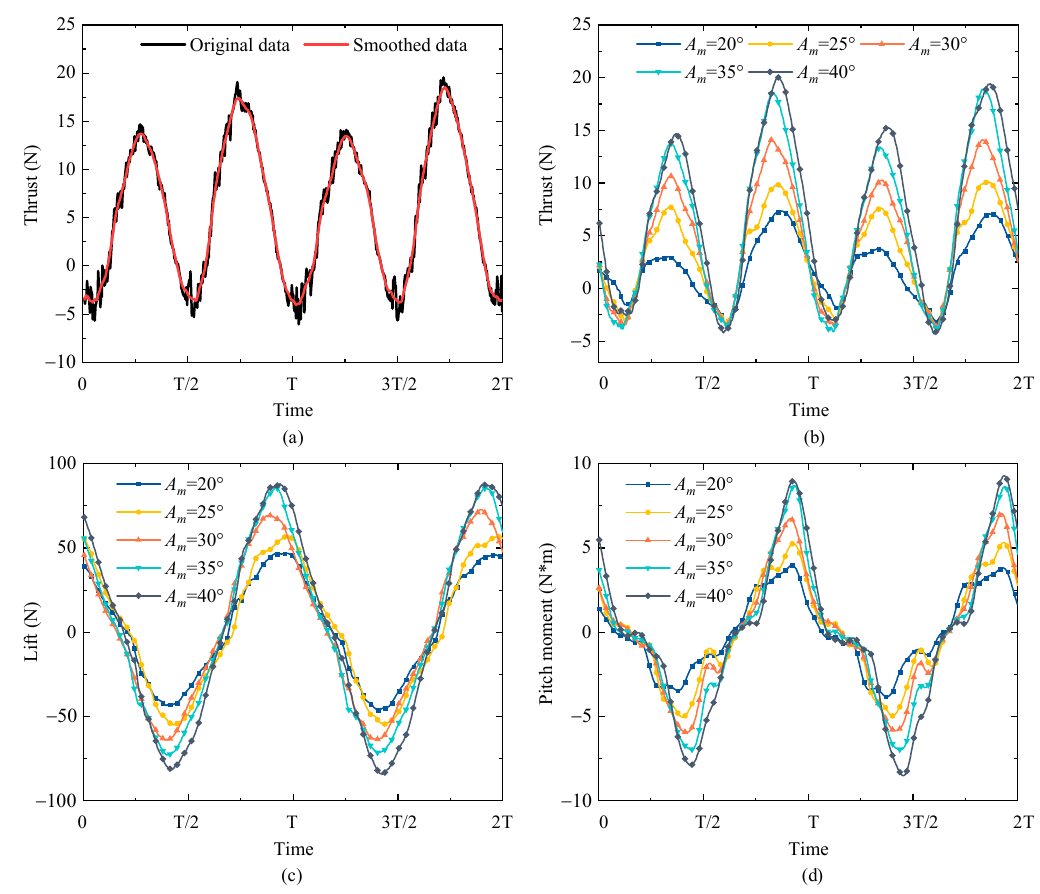
Figure 9. Data smoothing and comparison. ( a ) Comparison of the original data and smoothed data. ( b ) Thrust variation with time ( f = 0.34Hz, ∆ ϕ = 10 ◦ ). ( c ) Lift variation with time ( f = 0.34Hz, ∆ ϕ = 10 ◦ ). ( d ) Pitching moment variation with time ( f = 0.34Hz, ∆ ϕ = 10 ◦